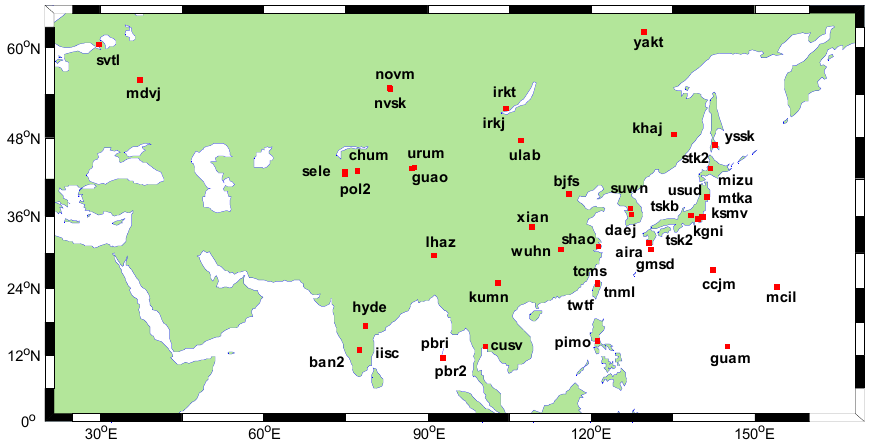
Figure 1. Distribution of the IGS sites in Asia. The abscissa represents longitude, and the ordinate represents latitude.